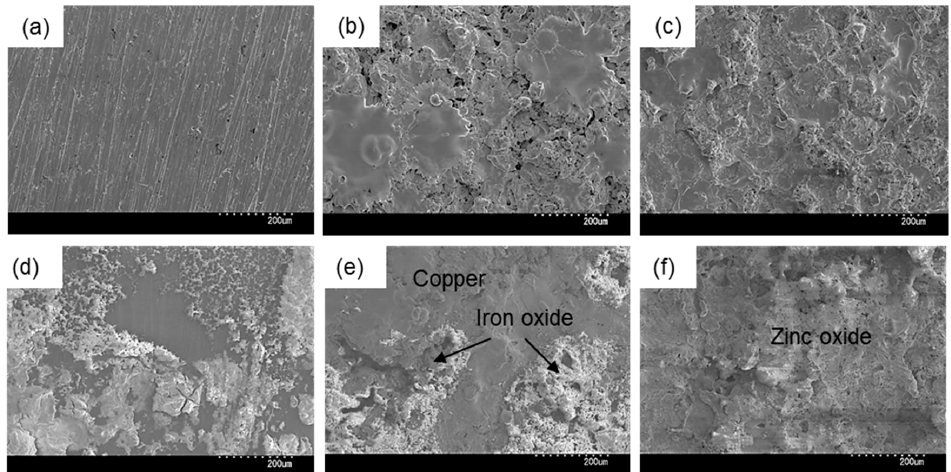
Figure 12. SEM images of the surface of coupons before ( a–c ) and after ( d–f ) LBR immersion testing. a and d : SS400; b and e : Cu-coated; c and f : Zn-coated.